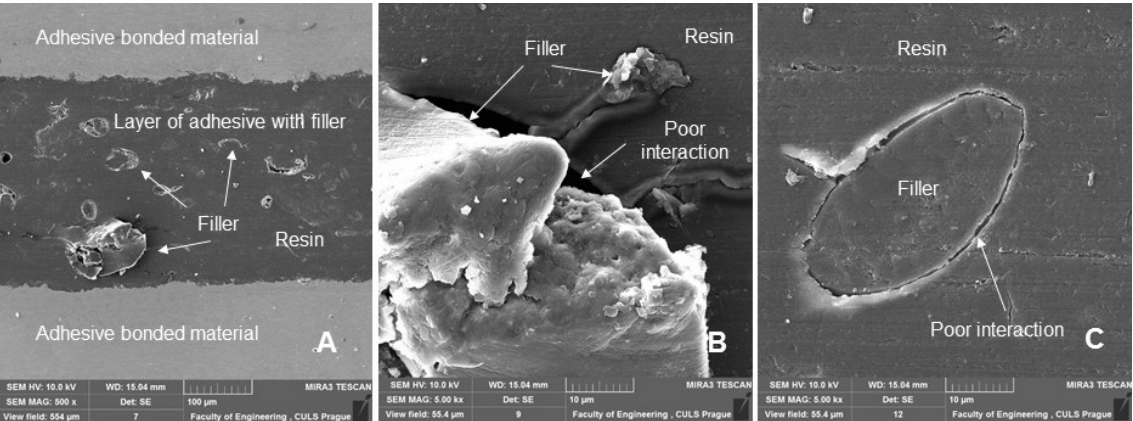
Figure 13. SEM images of an adhesive bond section with a biological filler based on coconut micro- particles—designation AB20, quasi-static test from 5 to 50% (157–1567 N), 1000 cycles: ( A ): adhesive bond section (MAG 500 ×), ( B ): section of the adhesive bond with a detailed view of the interaction of filler and resin (MAG 5.00 k×), ( C ): section of the adhesive bond with a detailed view of the inter- action of filler and resin (MAG 5.00 k×).